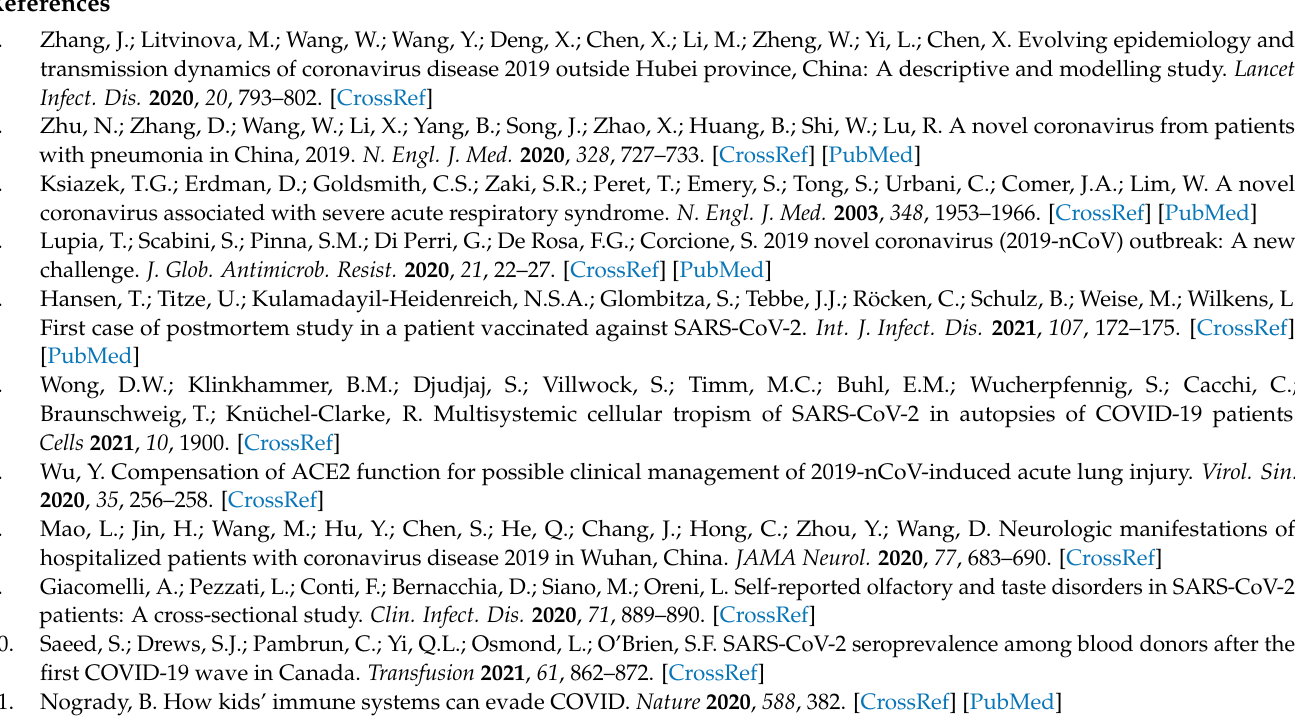
shown as sticks. Figure S6: The root mean square deviation curves of A9 and A14 relative to their initial